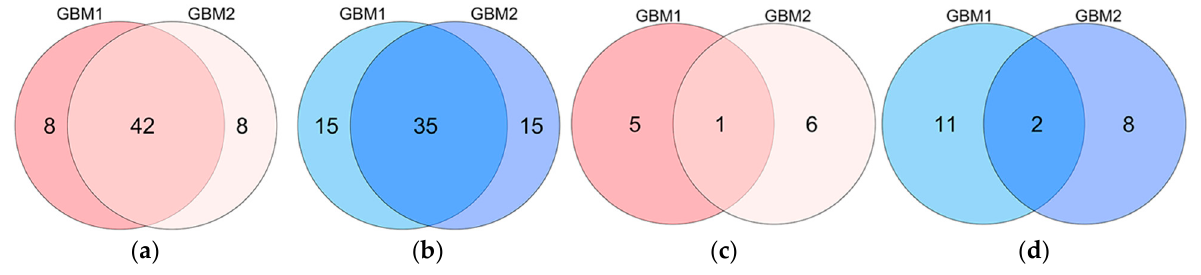
Figure 2. Venn diagrams of the numbers of original ( a , b ) and selected ( c , d ) genes in the GBM1 and GBM2 datasets, respectively. ( a , c ) represents the overexpressed genes in GBM samples; ( b , d ) represents the underexpressed genes in GBM samples.